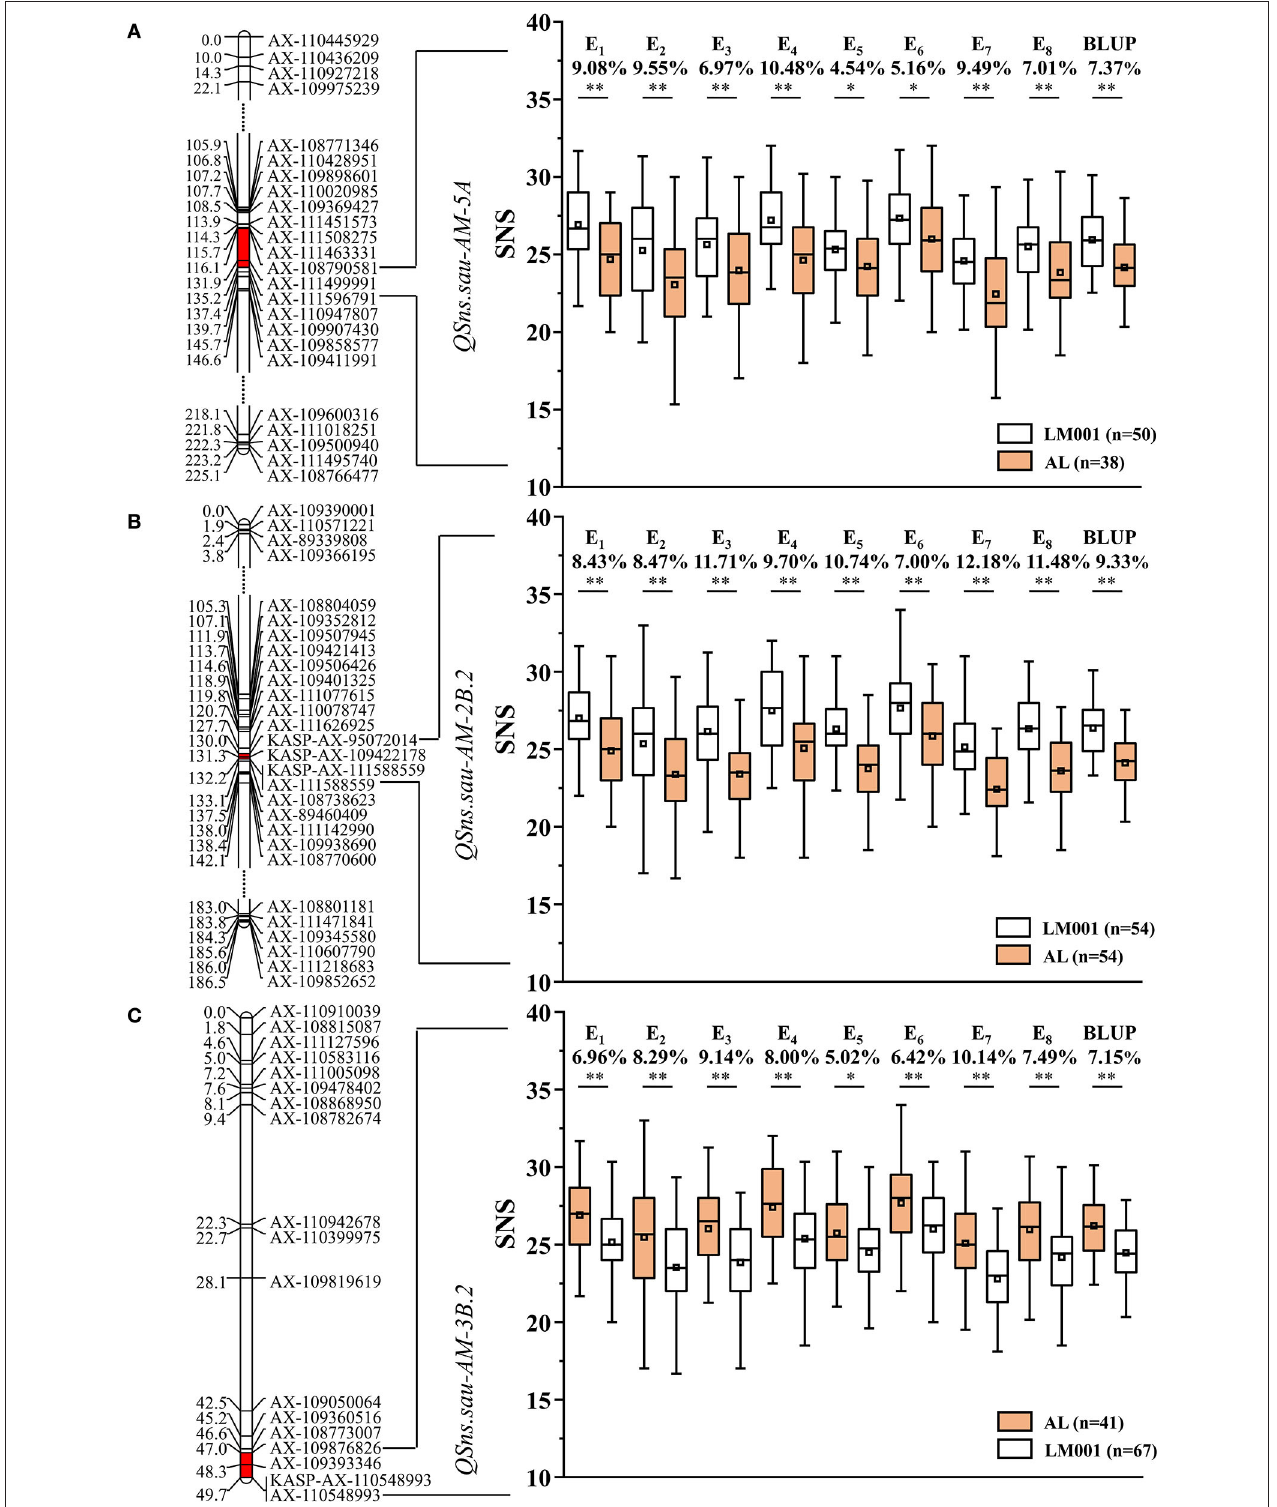
FIGURE 4 | AM recombinant inbred lines (RILs) were divided into two haplotype groups based on the genotype of flanking markers, and the SNS differences caused by the corresponding quantitative trait loci (QTL) were represented. Genetic maps of (A) QSns.sau-AM-5A , (B) QSns.sau-AM-2B.2 , and (C) QSns.sau-AM-3B.2 and their effects. *Significance level at p < 0.05, **Significance level at p <